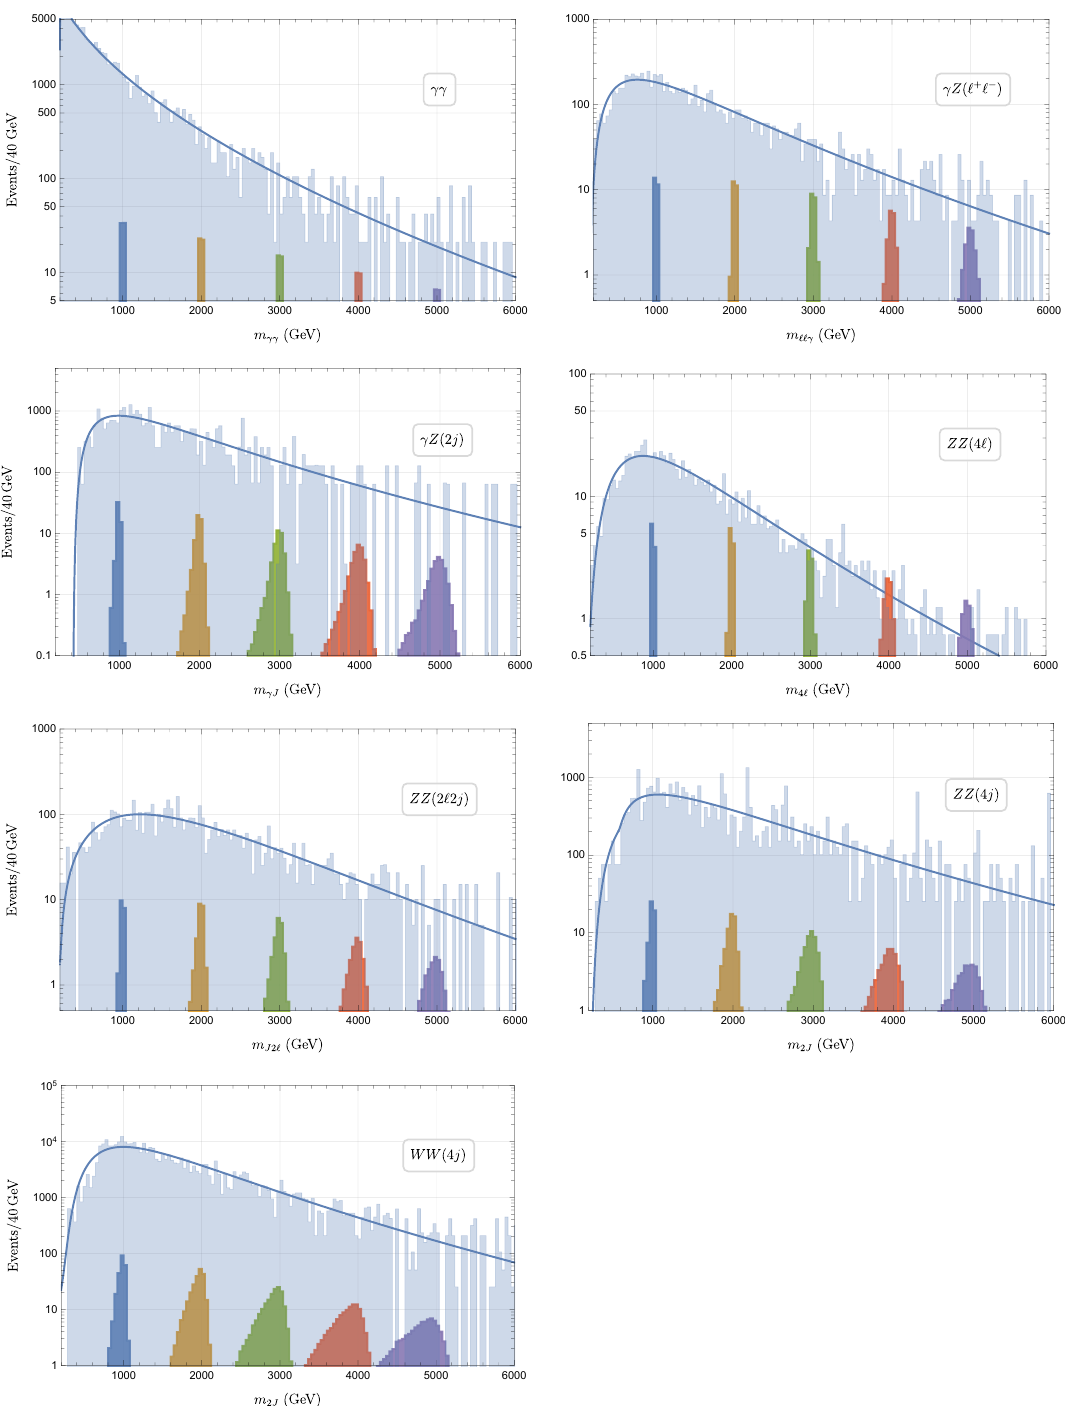
Figure 7 . SM backgrounds vs. ALP resonance signals for various ALP masses ( m a = 1, 2, 3, 4, 5 TeV) at a 14 -TeV muon collider with L = 10 ab − 1 . Simulated data are shown in histograms with a bin width of 40 GeV while fitted background distributions are shown as solid curves. For all signal peaks, the cross sections are normalized to their 2 σ exclusion